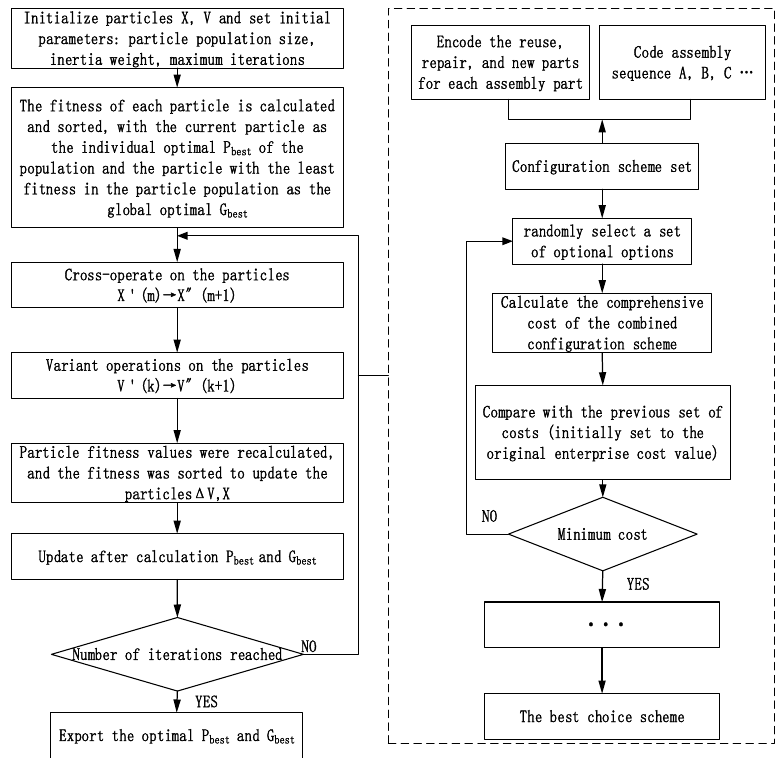
Figure 1. Combined algorithm solution step.